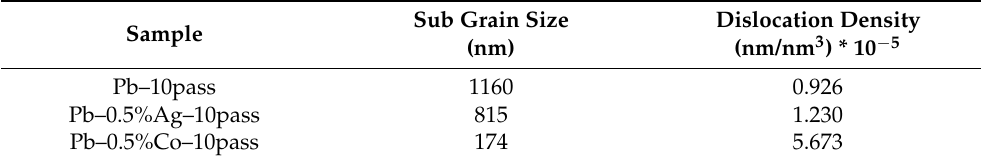
Table 4. Sub-grain size and dislocation density obtained by the Rietveld XRD analysis method.